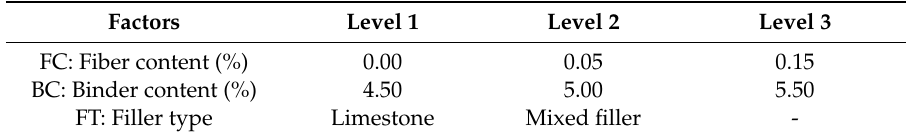
Table 5. Control factors with their corresponding levels.